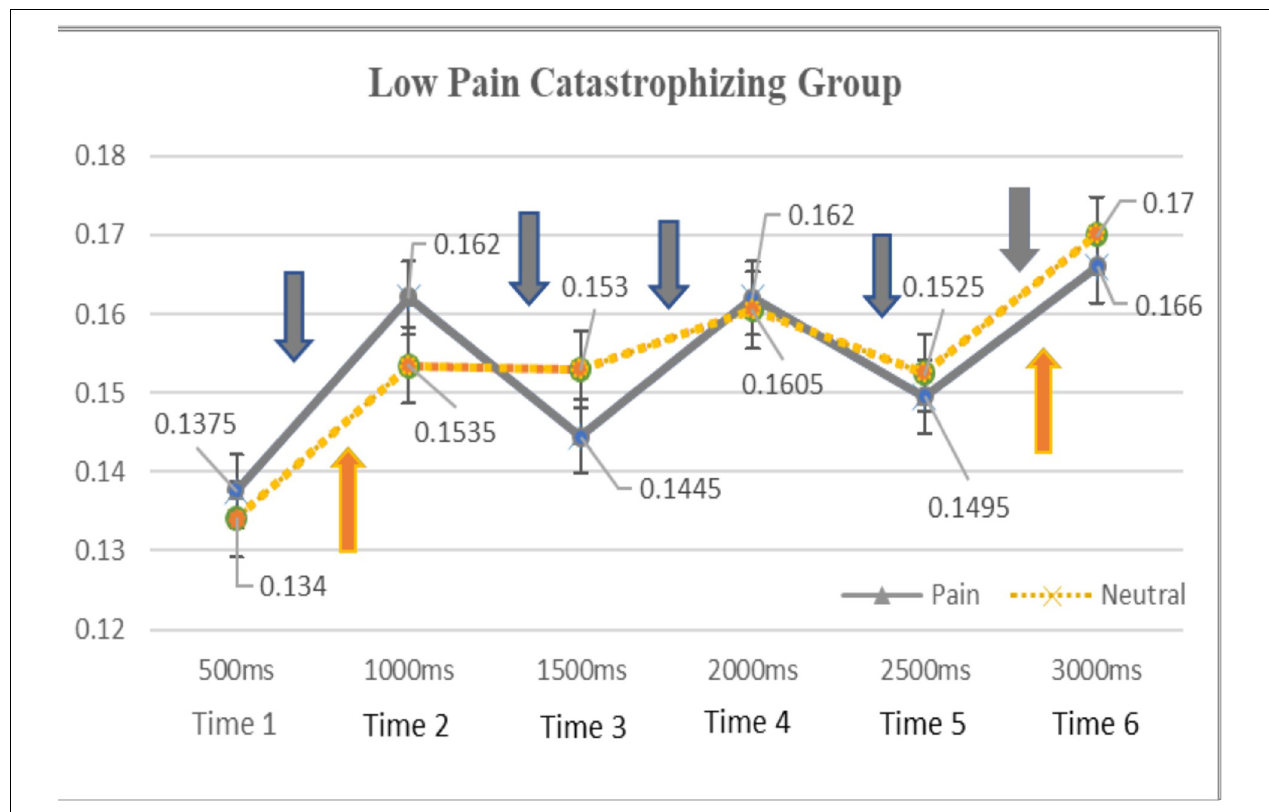
FIGURE 2 | Means of total gaze durations to pain and neutral facial stimuli by time (low pain catastrophizing group). Means of total gaze durations for pain and neutral stimuli were labeled and standard deviation bars were also included for each time point. Down-arrow symbol = significant differences in gaze durations of pain stimuli between time 1–2, time 2–3, time 3–4, time 4–5, time 5–6. Up-arrow symbols = significant differences in gaze durations of neutral stimuli between time 1–2 and time 5–6. No significant differences were found between pain and neutral stimuli for all time point. TABLE 4 | Means/SD and t -test results of the initial fixation and total gaze durations by groups. Expression t p Cohen’s